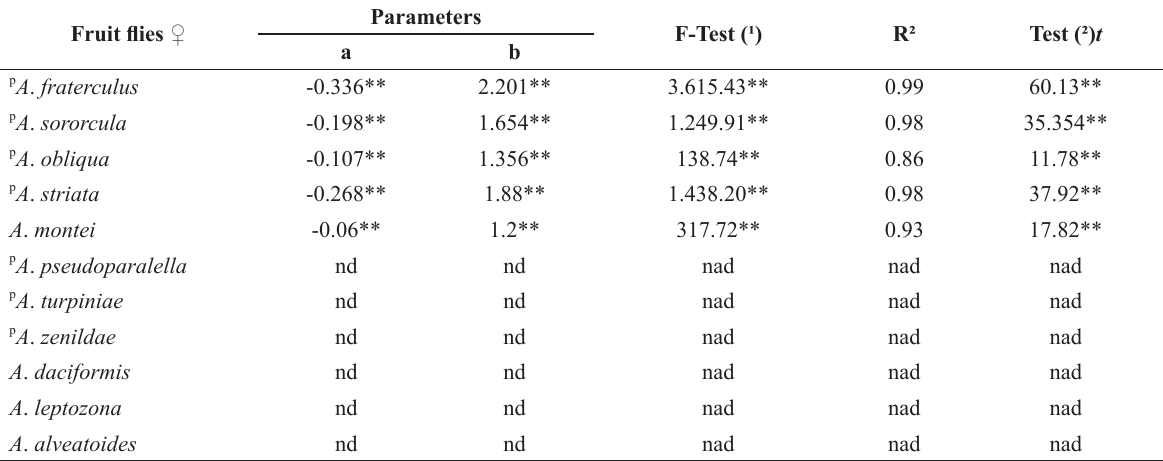
Taylor parameter estimates and regression analysis evaluating the distribution of adults of Anastrepha (Diptera: Tephritidae) species in Novo Millennium guava orchards for 23 weeks in the municipality of Ivinhema, State of Mato Grosso do Sul, Brazil (August 2013 to January 2014).